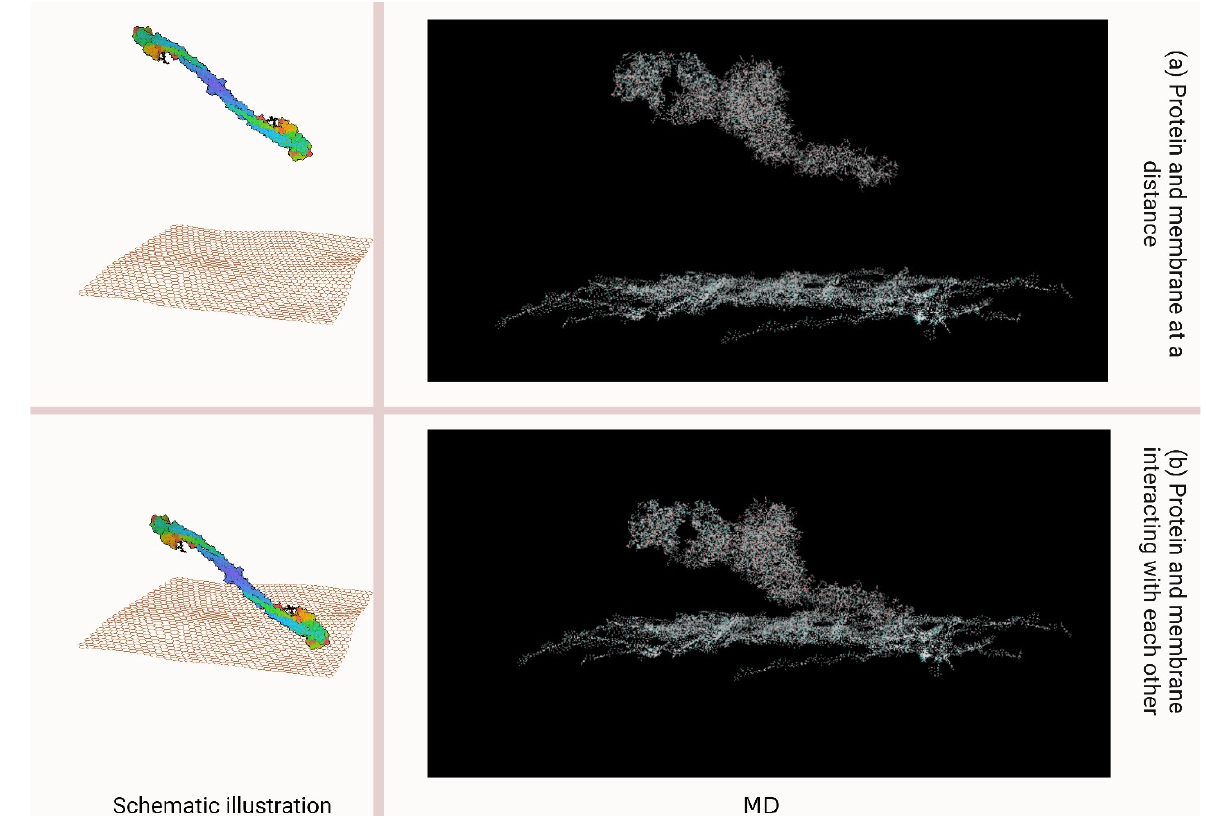
Figure 4. Total energy trend between FB and PAES membrane model.